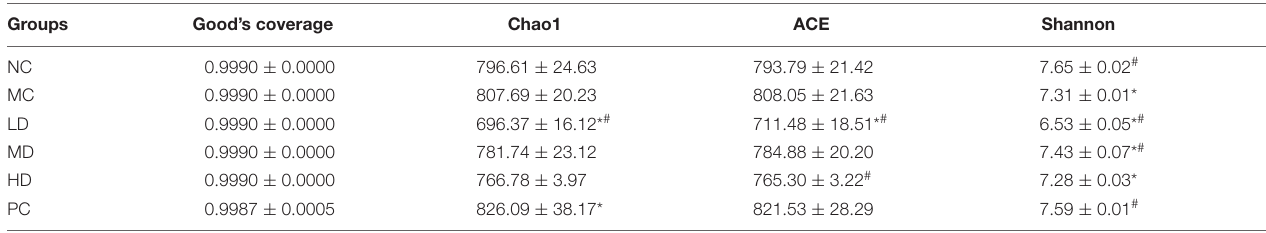
TABLE 3 | Alpha diversity analysis of the gut microbiota in different groups.